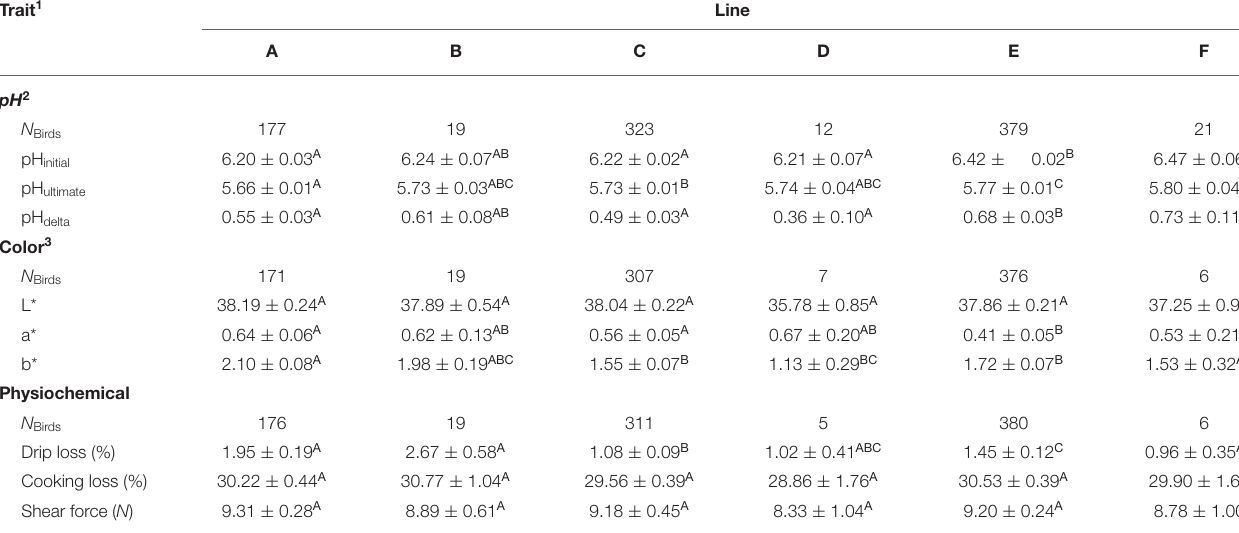
TABLE 5 | Differences in meat quality attributes between six genetic lines (A–F) of turkeys ( N Birds = 817–895 depending on trait). Trait